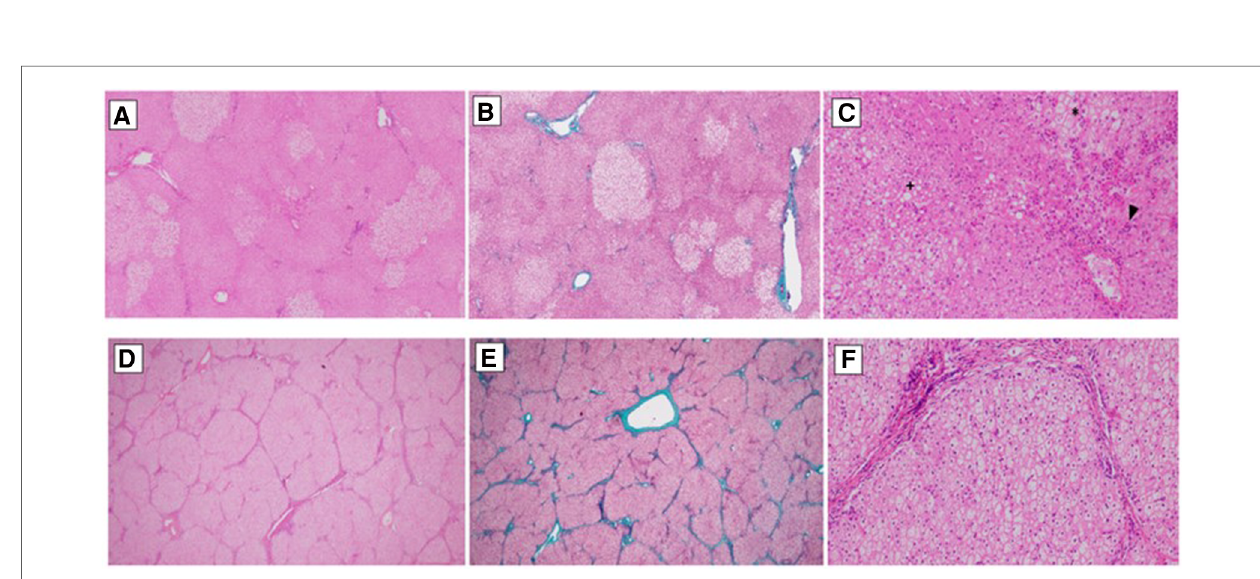
FIGURE 2 Pictures ( A – C ) show the liver explant histology of a patient diagnosed with OTC (ornithine transcarbamylase de fi ciency). ( A ) Preserves hepatic architecture. Patchy clear hepatocytes with no zonal distribution. Haematoxylin&Eosin, 20×. ( B ) There is no signi fi cant fi brosis. Masson ’ s Trichrome, 20×. ( C ) Hydropic/glycogenated hepatocytes (*) admixed with macrovesicular steatotic patches (+). Around the central veins, sinusoidal aggregated neutrophils can be seen (surgical hepatitis, arrowhead). Haematoxylin&Eosin, 20×. Pictures ( D – F ) belong to a patient diagnosed with ASL (argininosuccinate lyase de fi ciency). ( D ) Micronodular liver architecture with both complete and incomplete septae. Haematoxylin&Eosin, 20×. ( E ) Both portal to portal and portal to central septae can be seen. Masson ’ s Trichrome, 20×. ( F ) Hepatocytes are uniformly swollen, wih clear cytoplasm and prominent cell membrane. Masson ’ s Trichrome,